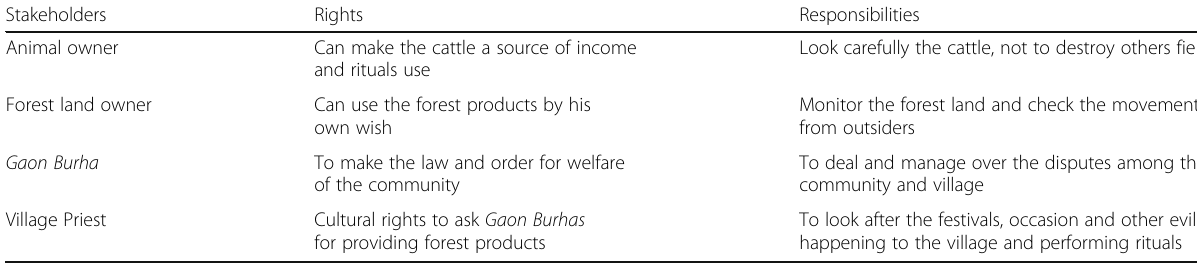
Table 4 Stakeholders ’ rights and responsibility in relation to the forest resources